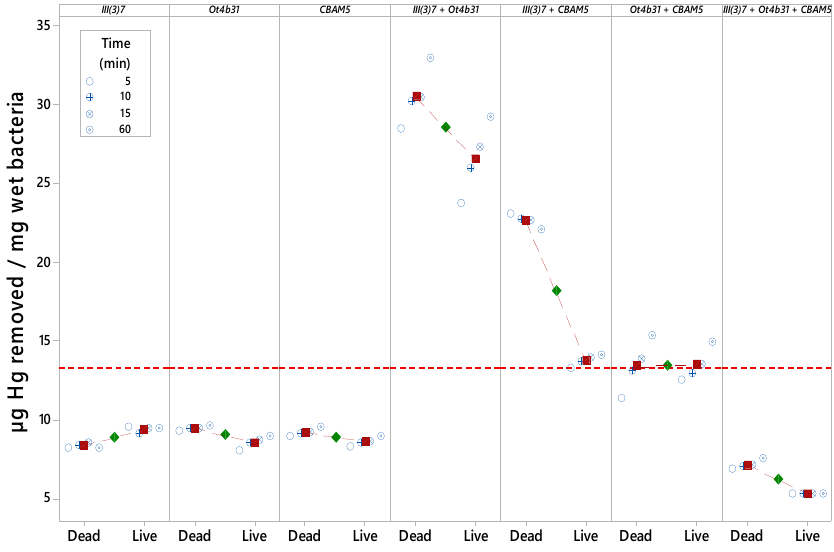
Figure 1. Efficiency in mercury removal by L. sphaericus (strains alone and mixtures) over time.